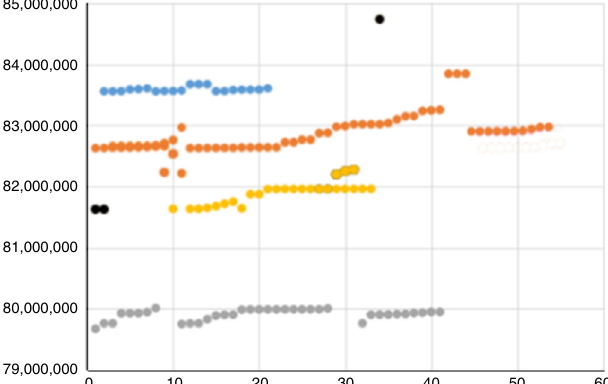
Figure 19. Result of our algorithm on “ MOOCs ” data